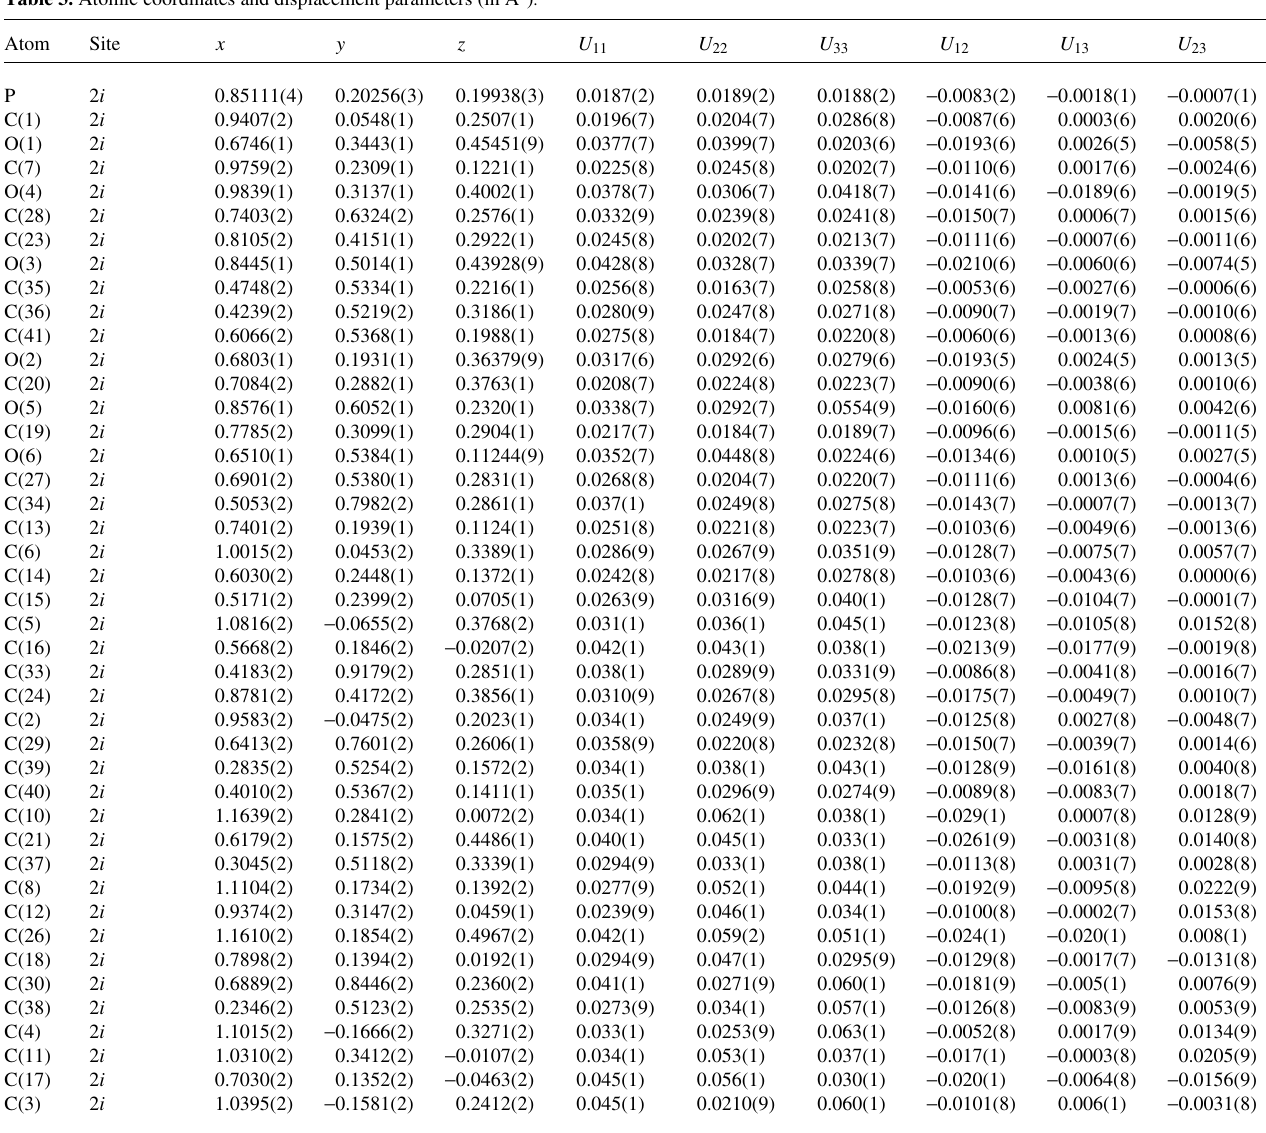
Table 3. Atomic coordinates and displacement parameters (in Å 2 ) .